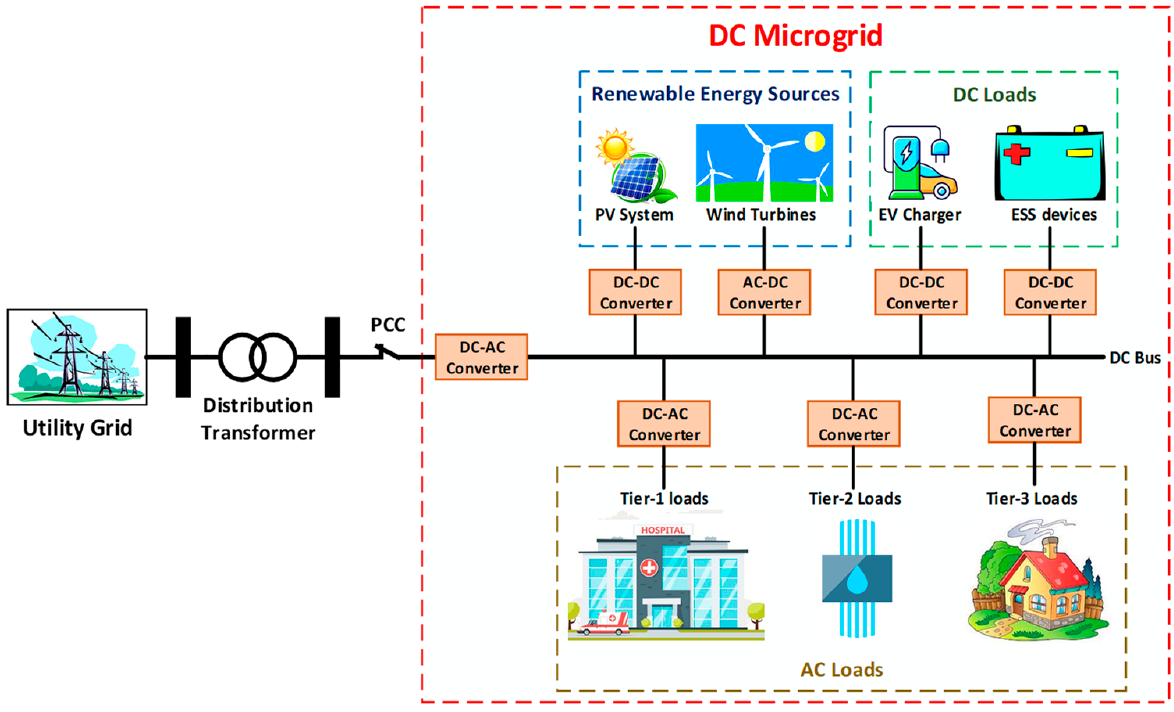
Figure 2. Simple diagram of a typical DCMG.